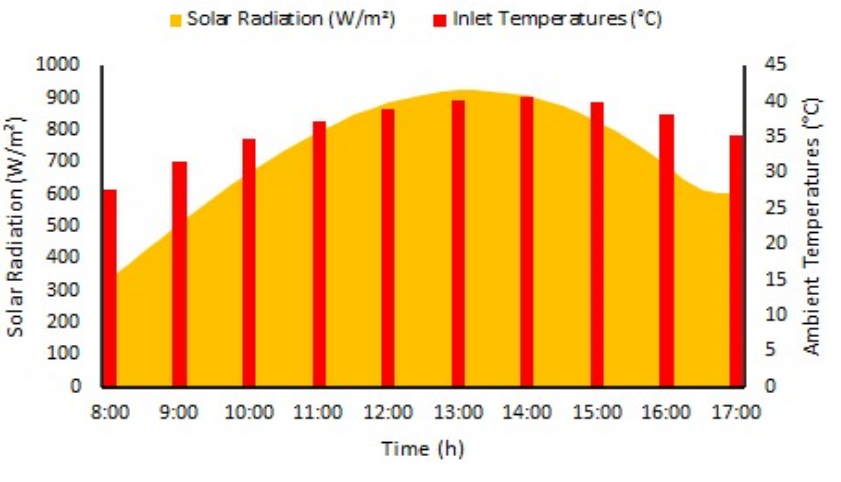
Figure 2. Solar Radiation and ambient Temperatures over a typical day